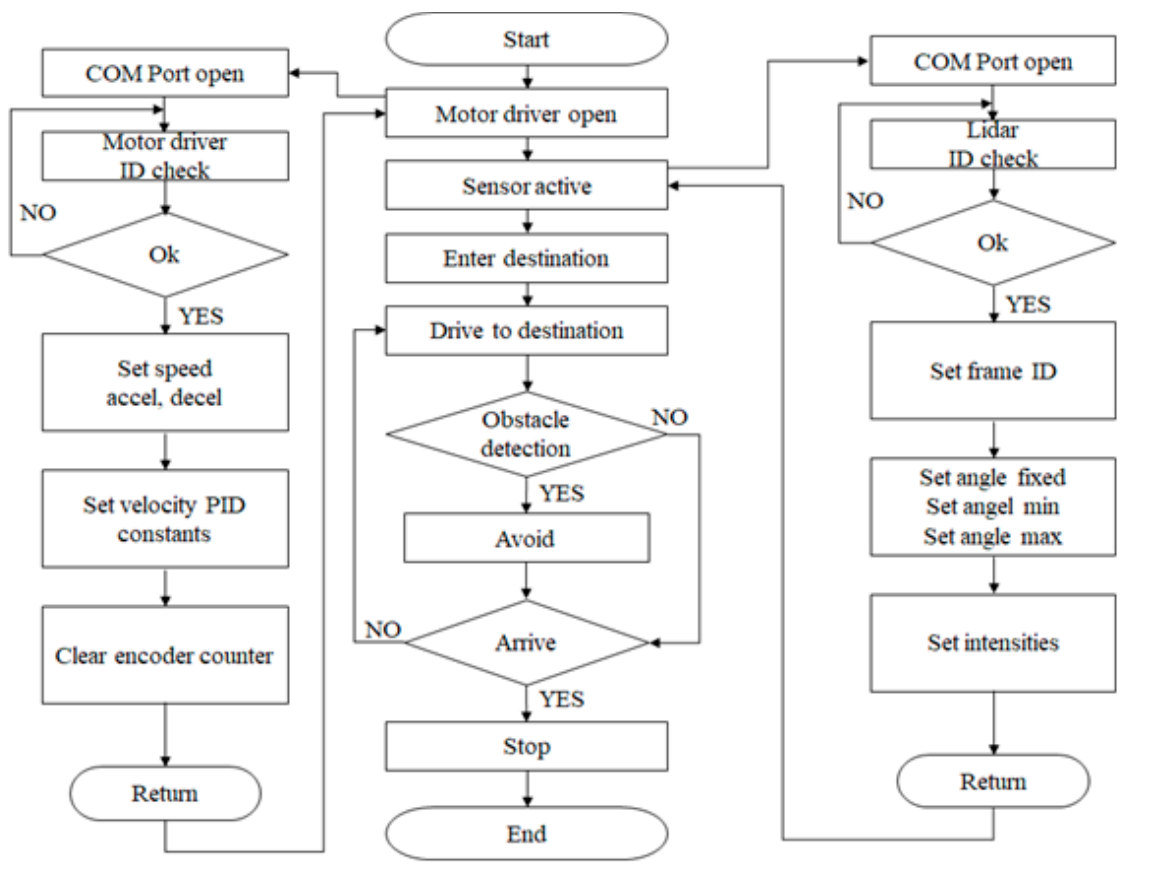
Figure 9. Flowchart of the algorithm controlled at the main controller for autonomous driving.